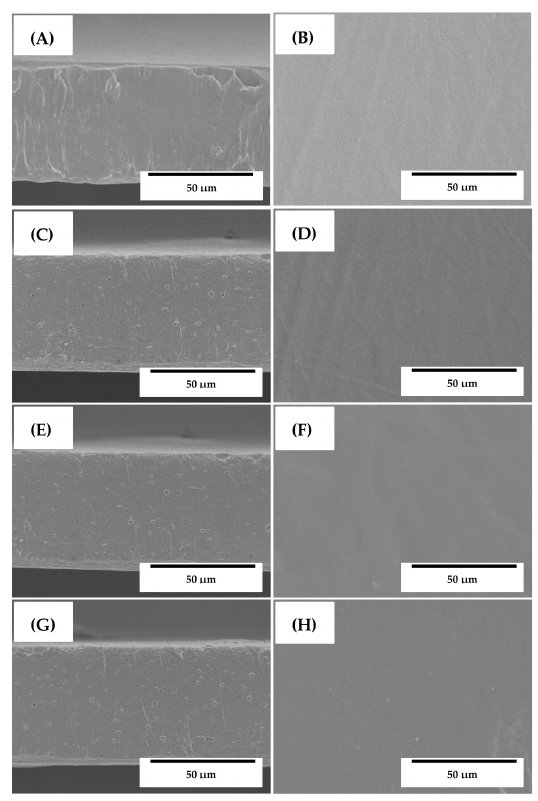
Figure 2. Scanning electron microscopy (SEM) micrographs of the electrospun films in their cross-section (left column) and top view (right column) of: ( A , B ) Neat poly(3-hydroxybutyrate- co -3- hydroxyvalerate) (PHBV); ( C , D ) Oregano essential oil (OEO)-containing PHBV; ( E , F ) Rosemary extract (RE)-containing PHBV; ( G , H ) Green tea tree extract (GTE)-containing PHBV. Scale markers of 50 µ